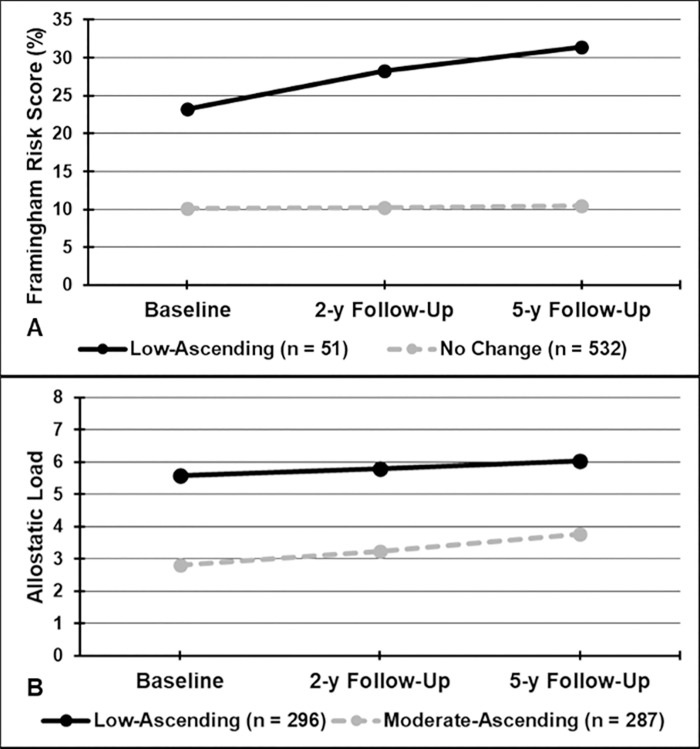
Predicted Trajectories for: A) Framingham Risk Scores; and B) Allostatic Load.